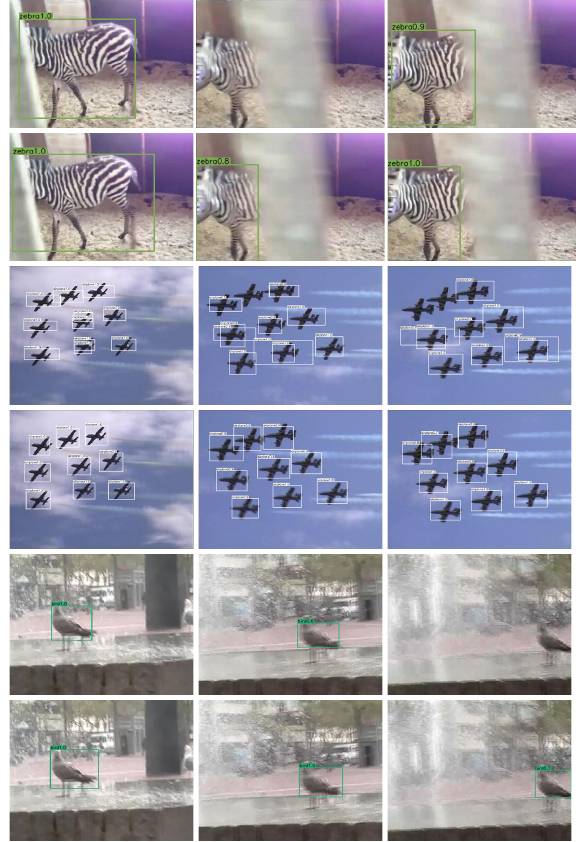
Figure 5. Detection samples.